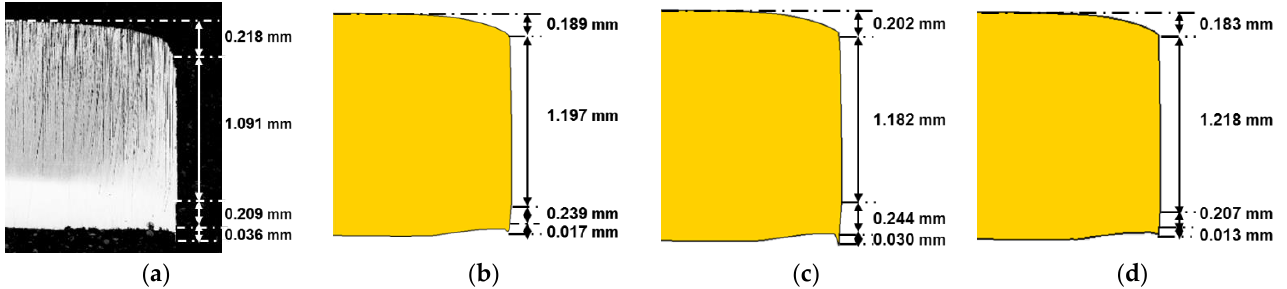
Figure 4. Comparison of the experimental and analytical shear plane distributions; ( a ) experimental shear plane; ( b ) C 0.01; ( c ) C 0.011; ( d ) 0.012.